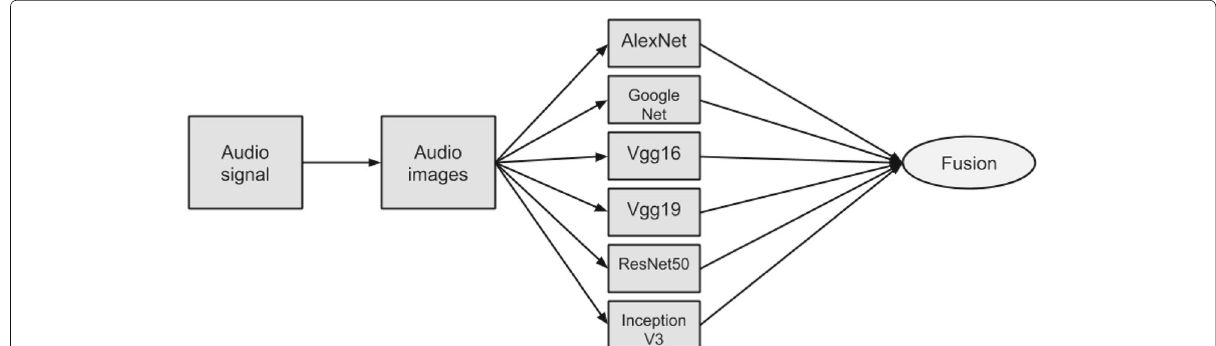
Fig. 5 Fusion of the sets of